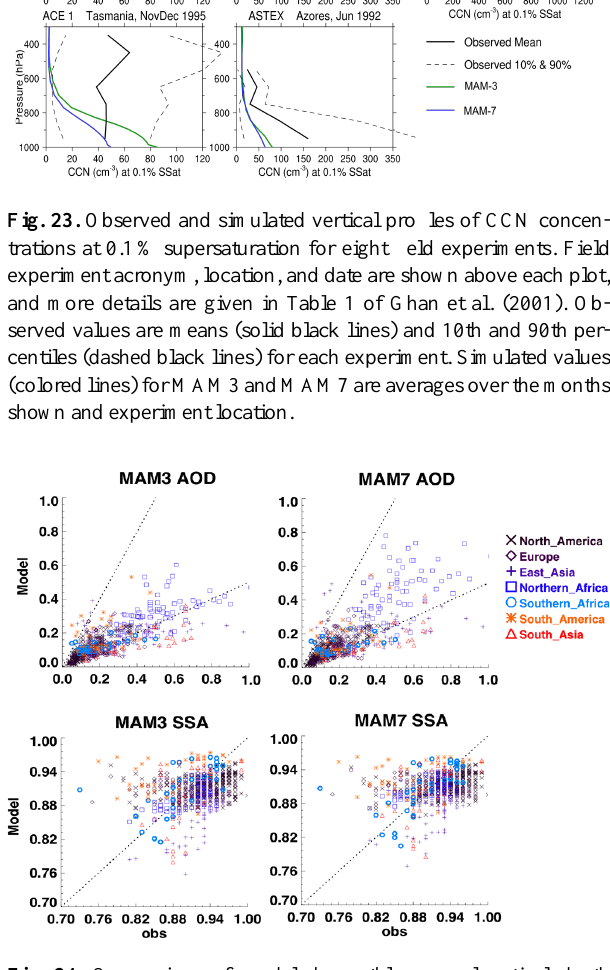
0.134 µm diameter non-hygroscopic particle, which is the volume-mean size for BC and POM emissions, the 3 and 8 monolayers of sulfate produce CCN with critical supersat- urations of 0.49 % and 0.32 %,